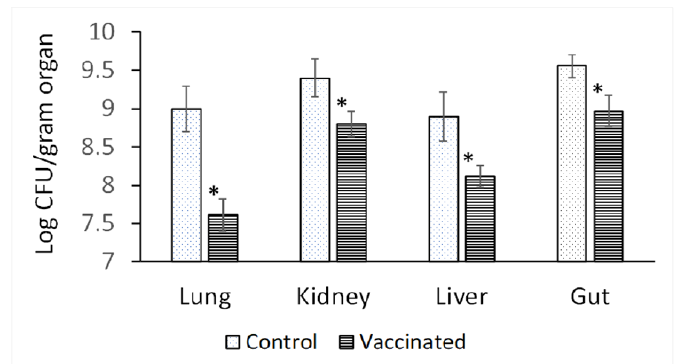
Figure 5. The bioburden of organs in challenged rats. Diabetic animals were orally vaccinated with 10 8 PAGs for a total of three doses at two-week intervals. On day 35, both vaccinated and unvaccinated groups were challenged orally with 10 8 CFU of P. aeruginosa , and organ bioburden was determined 5 days post-challenge. (*) p < 0.05 using Student’s t test (N = 6).